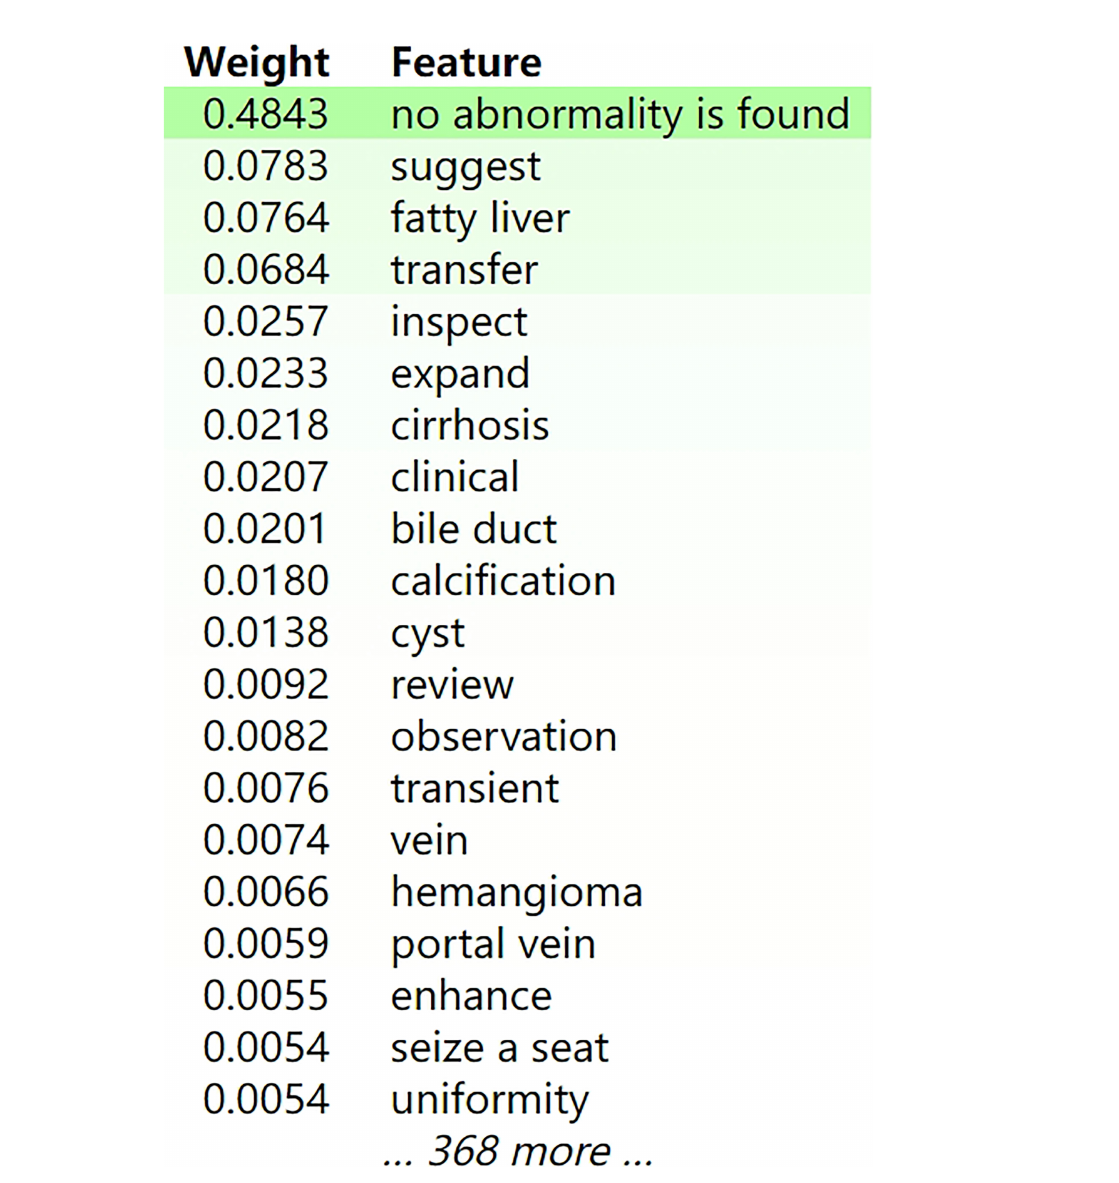
FIGURE 5 The feature weights of the XGBoost model for the general classi fi cation accuracy. Green represented positive correlation, and the weight represented the contribution. The darker the green, the stronger the correlation between the word and classi fi cation. For publication purposes, we provided English version of Chinese words from the imaging